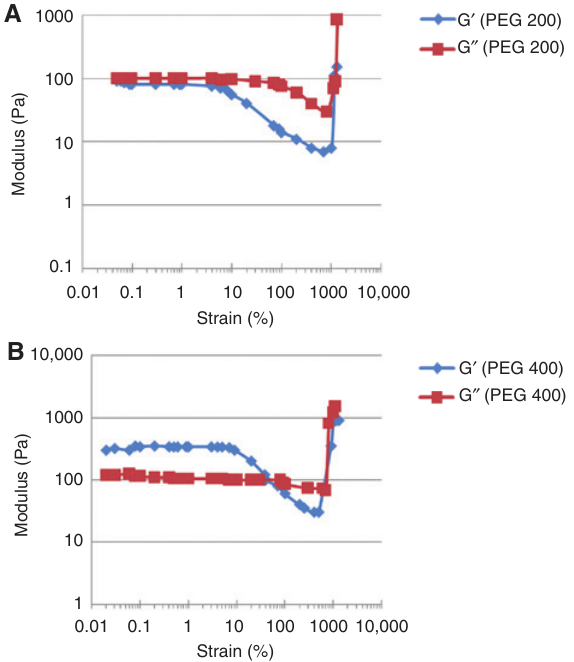
Figure 10: Modulus diagram based on strain percentage for the 30 wt% silica sample in (A) PEG 200 and (B) PEG